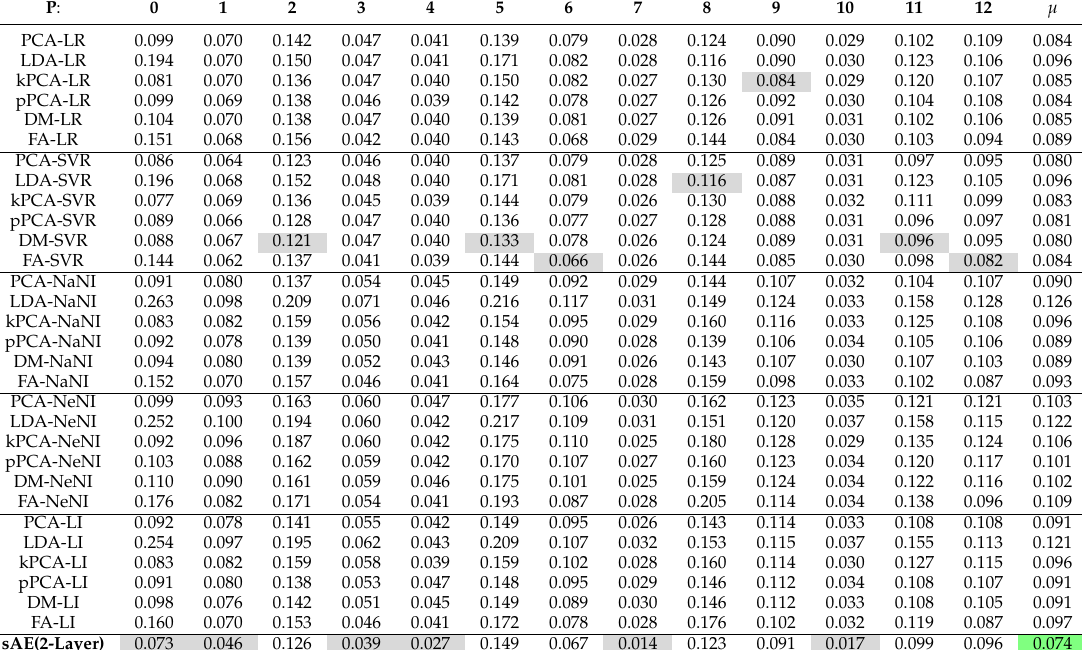
Table 4. Mean reconstruction error per parameter using combinations of dimensionality reduction and reconstruction techniques, with the lowest reconstruction error highlighted in grey. The final column shows the mean ( µ ) error across all techniques, while the model with the lowest mean reconstruction error (Stacked Autoencoder, sAE) is highlighted in green. LR: Linear Regression; SVR: Support Vector Regression; NaNI: Natural Neighbour Interpolation; NeNI: Nearest Neighbour Interpolation; LI: Linear Interpolation.